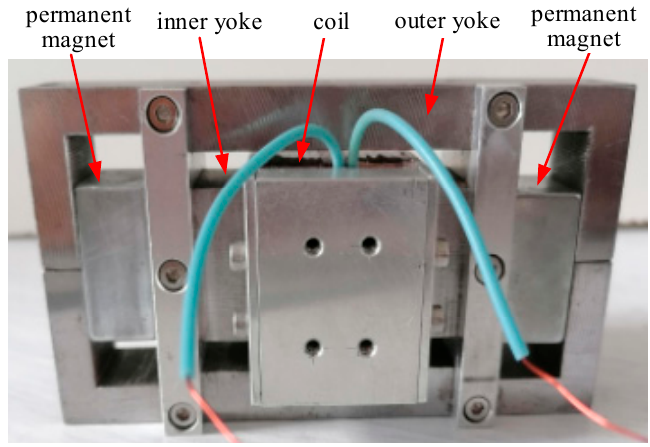
Table 1. Geometric parameters of an electromagnetic actuator.